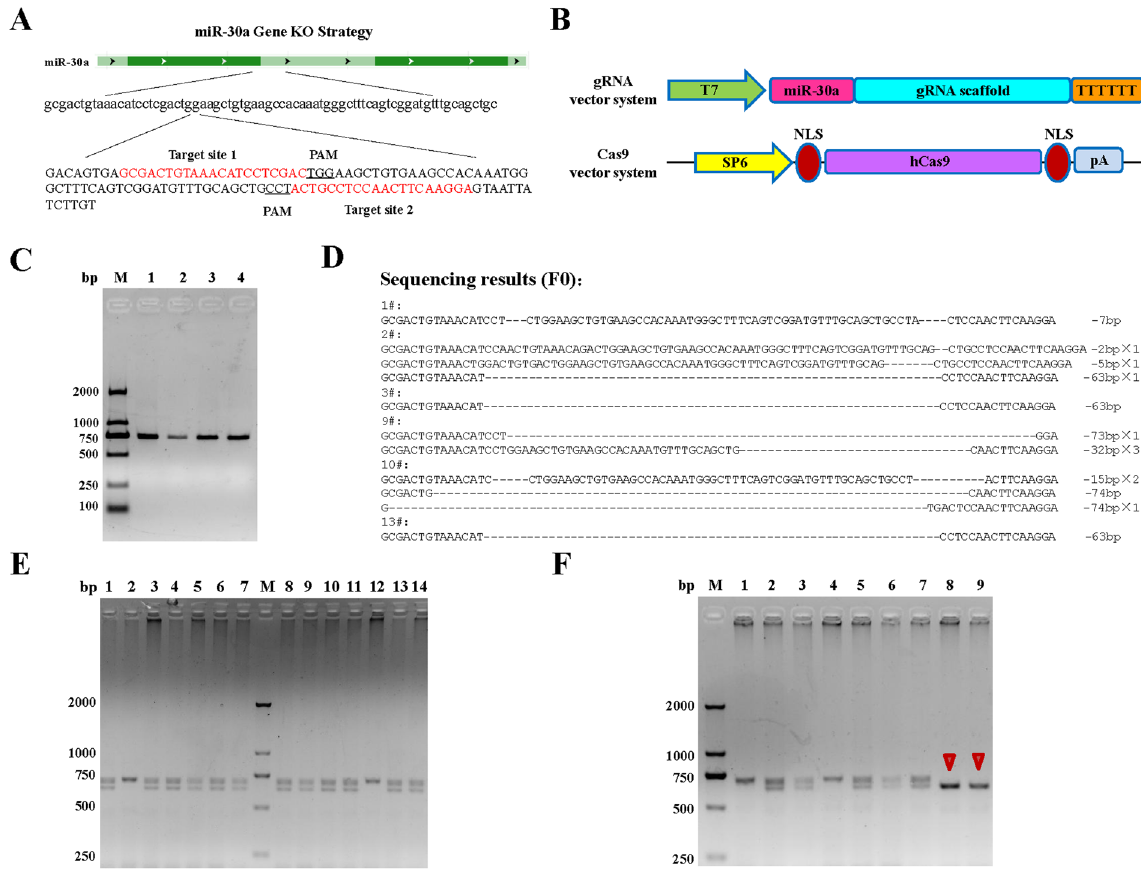
Figure 6. Construction of miR-30a knockout mouse model using CRISPR/Cas9 technology. ( A ) Two CRISPR nuclease gRNAs were designed for miR-30a knockout. ( B ) Schematic diagram of the gRNA vector system and Cas9 vector system. ( C ) In vitro transcription template (716 bp DNA fragment) was obtained by PCR amplification and characterized by gel electrophoresis and DNA sequencing. ( D ) Validation of CRISPR miR-30a knockout in F0 generation mice by PCR and DNA sequencing. ( E ) miR-30a heterozygous F1 generation mice were screened out by PCR amplification from the 14 posterity of F0 generation mice mating with wild-type mice. ( F ) Two miR-30a gene knockout homozygous mice (marked with red arrow) were identified from the 9 posterity of two-two mating of heterozygous F1 generation